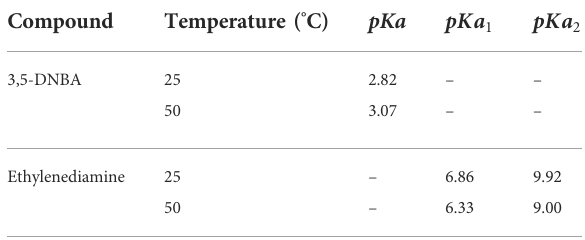
TABLE 1 Summary of literature dissociation constants for 3,5-DNBA and ethylenediamine (Kortum et al., 1961; Gupta and Soni, 1965; Hyde,